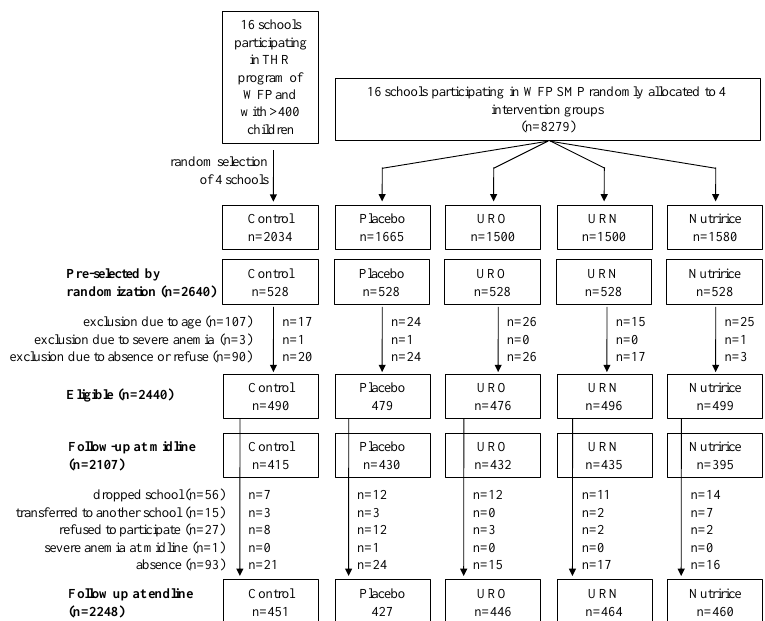
Figure 1. Trial profile. THR: take-home ration, URO: UltraRice original formulation, URN: UltraRice new formulation, WFP-SMP: World Food Program school-meal program.